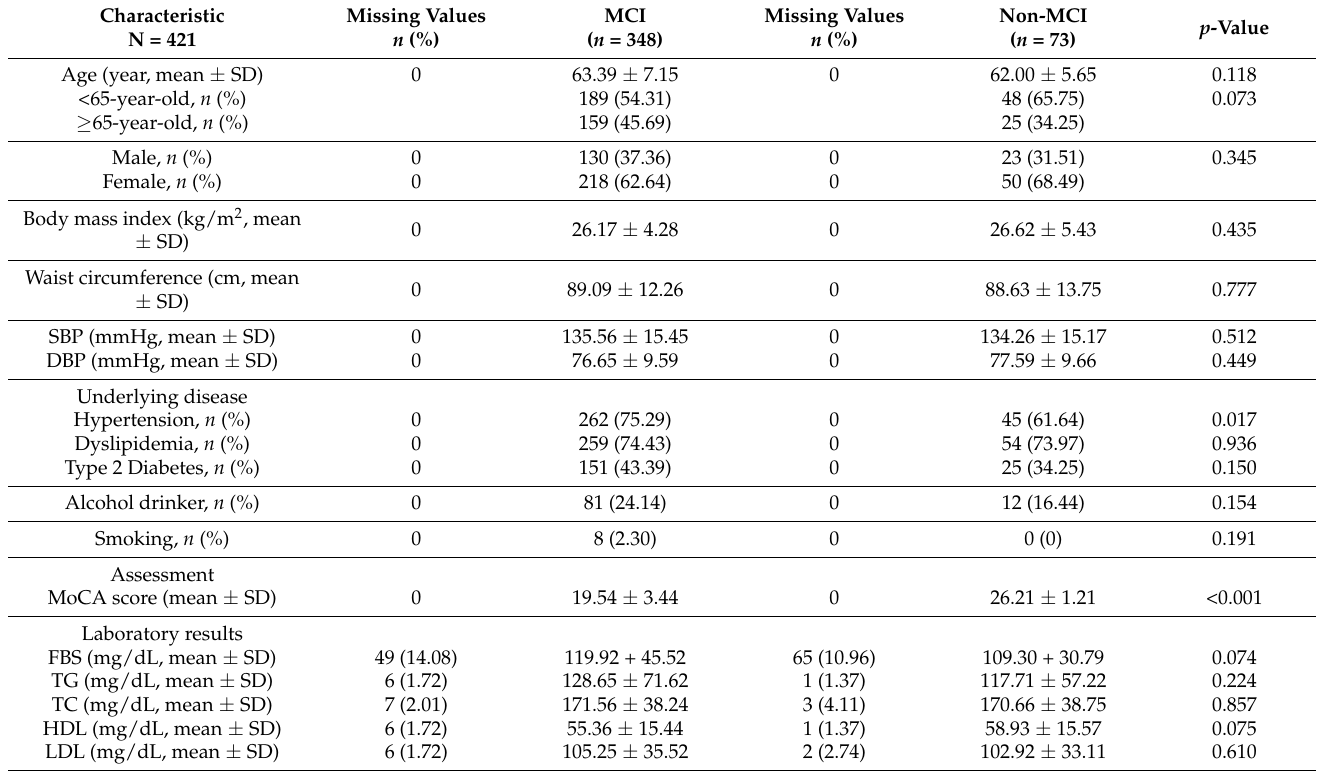
Table 1. Participant